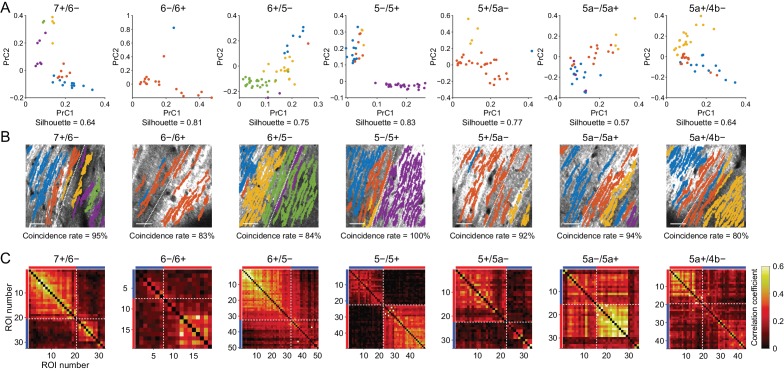
Broad correspondence between functional boundaries and AldC expression boundaries at cellular resolution.(A) Principal component analyses of whole ∆F/F traces from all ROIs in single imaging sessions at all AldC expression boundaries, irrespective of AldC expression. Colored dots correspond to results from k-means clustering on the basis of the first three principal components (PrC1, PrC2, and PrC3). The first two major principal components (PrC1 and PrC2) for individual ROIs are plotted for better visualization. The silhouette value for the optimized cluster number is indicated on the bottom. (B) Projections of each clustering result from panel (A) using the same color scheme, overlaid on the tdTomato image. Coincidence rates of clustering results and AldC expression are indicated at the bottom. Scale bars: 40 μm. (C) Correlation matrices of whole traces from all the ROIs in panel (B) aligned from lateral to medial. Red and blue bars correspond to AldC+ and AldC− PCs. Note the exact delineation of the correlation matrices at the AldC expression boundary where coincidence value is close to 100%. (B, C) White dashed lines represent boundaries of AldC expression.